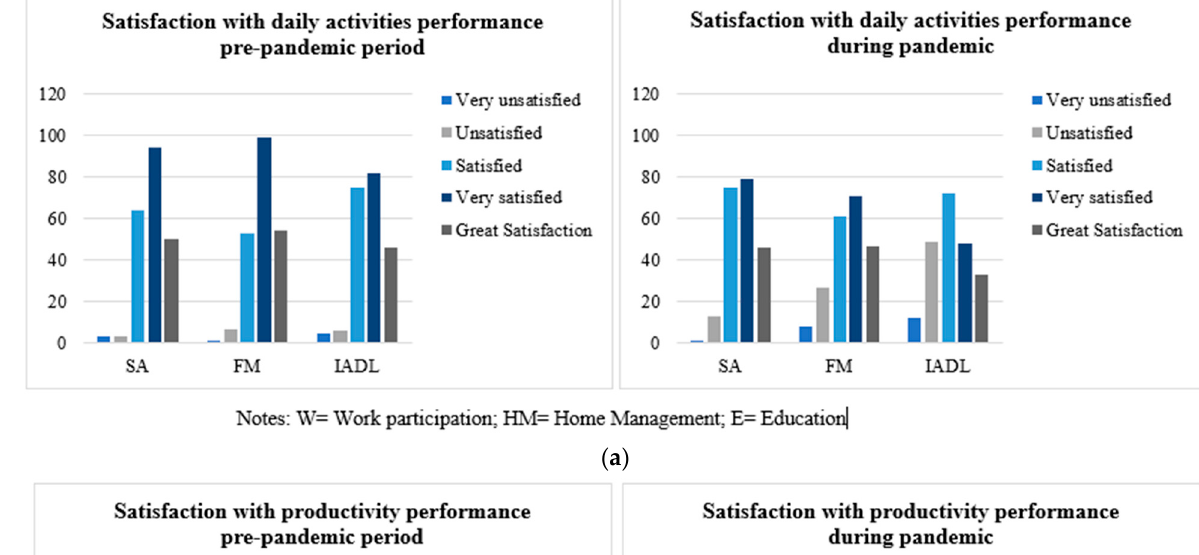
Figure 3. Activities where they present performance difficulties.